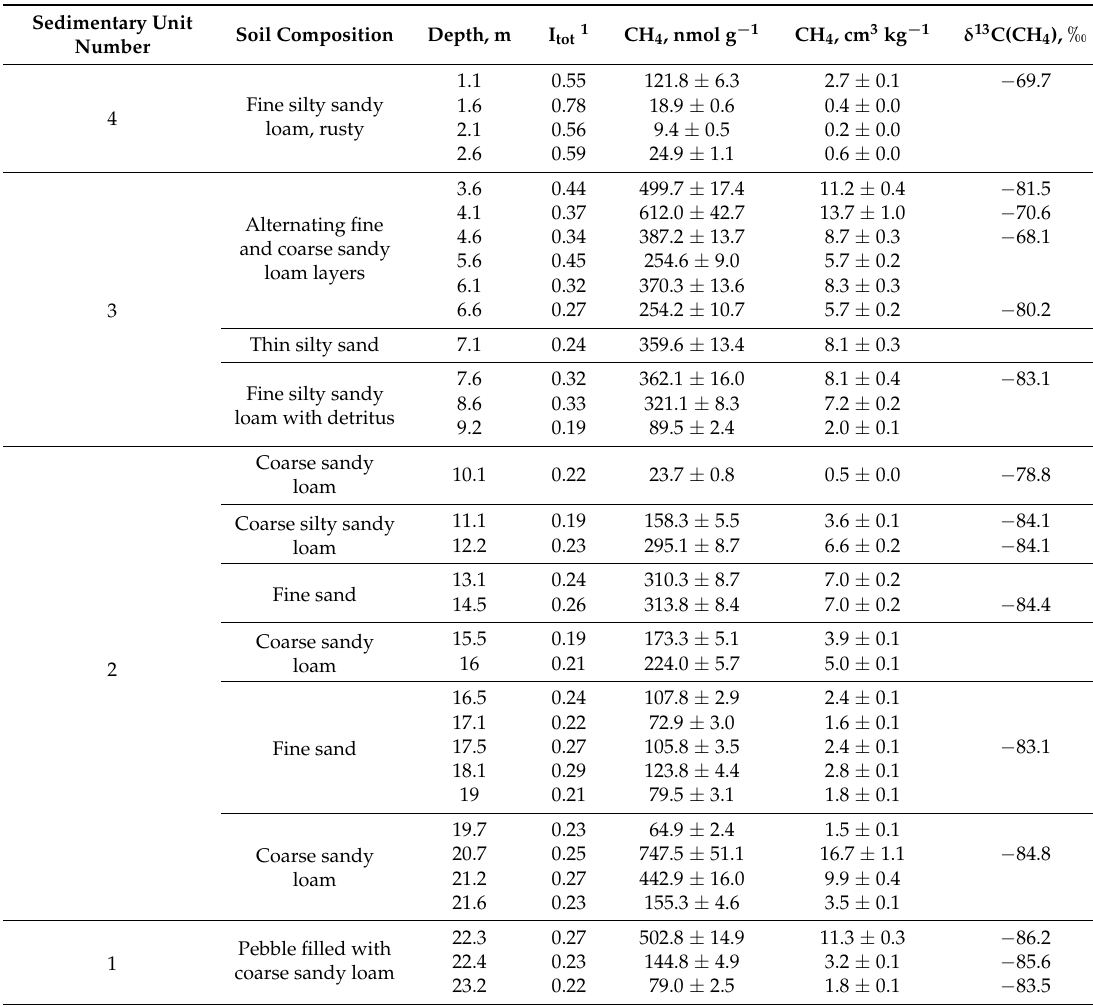
Table A1. Methane concentration and isotopic composition in the sediments extracted from the core in Kolyma floodplain, Borehole